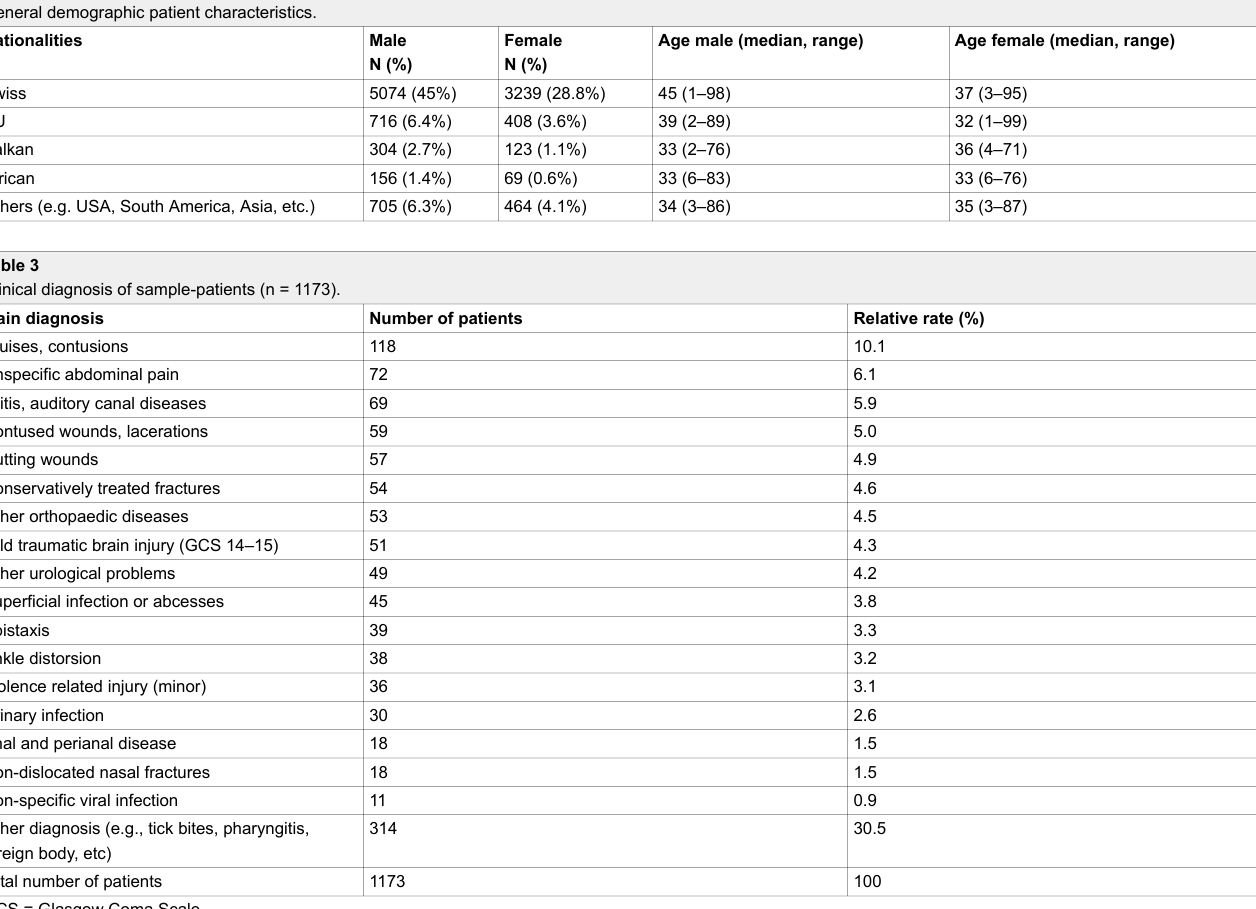
Table 2 General demographic patient characteristics.